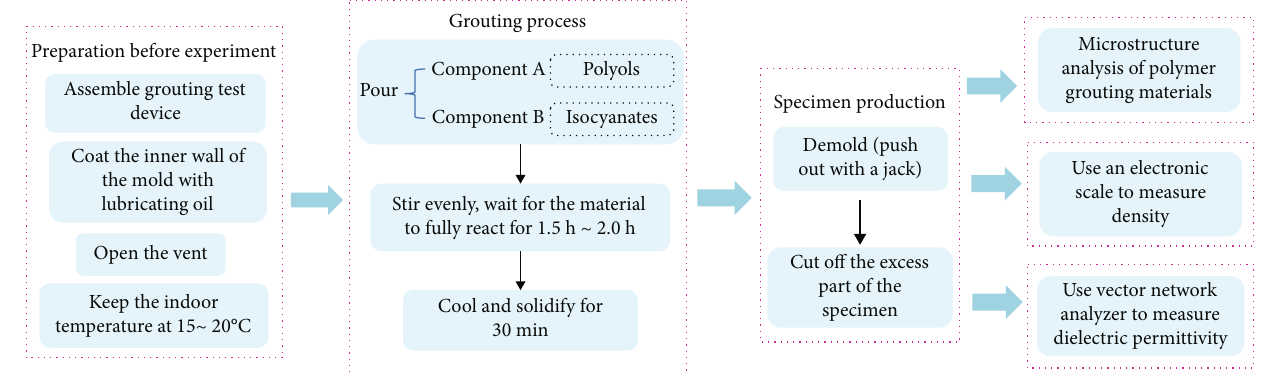
Figure 2: Schematic diagram of the experimental process fl ow.